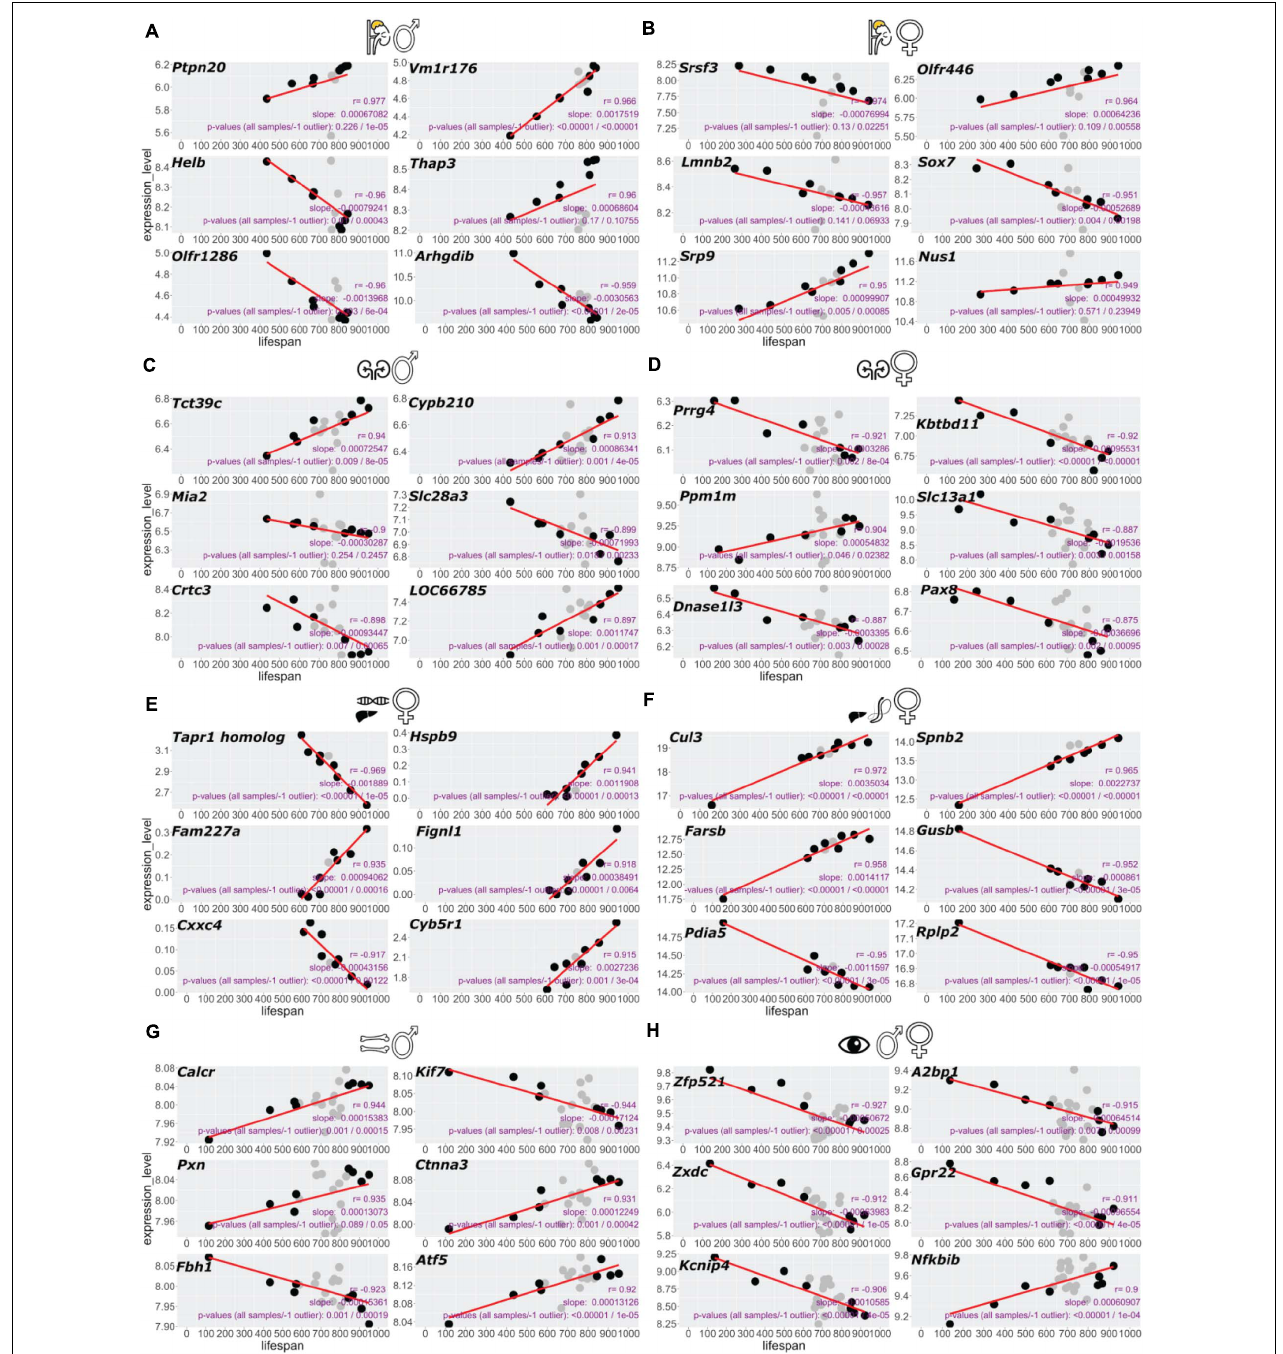
FIGURE 2 | Top six genes correlating with BXD lifespan in each dataset. Gene expression correlating with lifespan scored by highest Pearson’s R for each tissue. Adrenal gland male (A) , female (B) , kidney male (C) , female (D) , female liver RNA-seq (E) , liver female proteomics (F) , bone femur male (G) , and sex-combined eye tissue (H) . (A–E,G,H) RNA-seq or microarray data and (F) proteomics